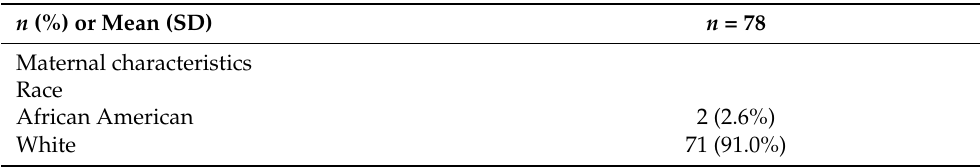
Table 1. Maternal and infant characteristics at